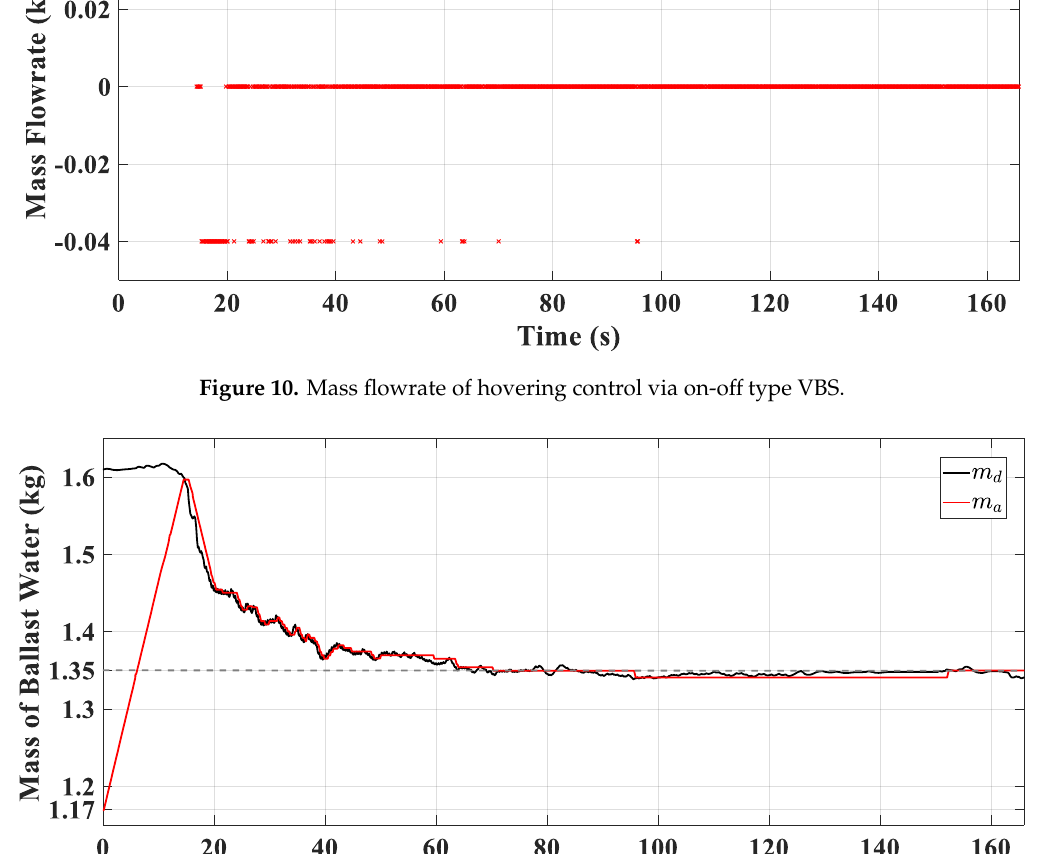
Figure 12. Ballast mass tracking error of hovering control via on-off type VBS. Figure 13. Depth response of hovering control via on-off type VBS.